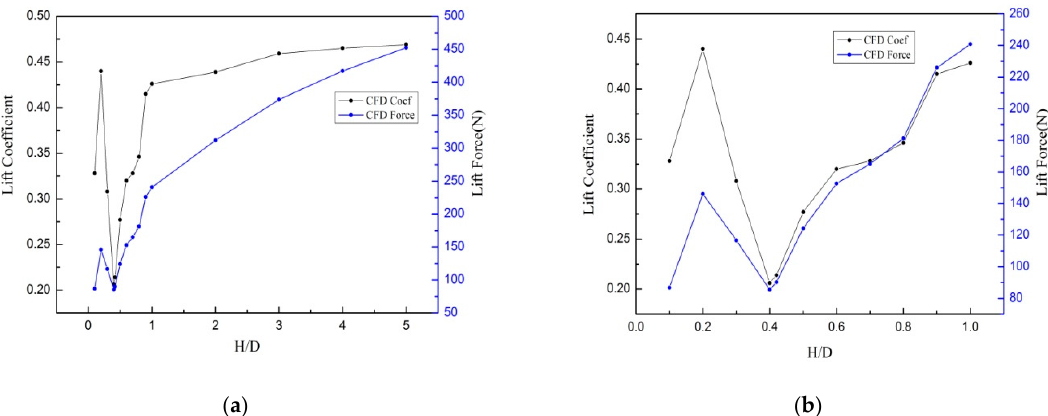
Figure 8. Time averaged lift coefficient and lift force with different aspect ratios: ( a ) the whole figure; ( b ) the partial enlargement figure.